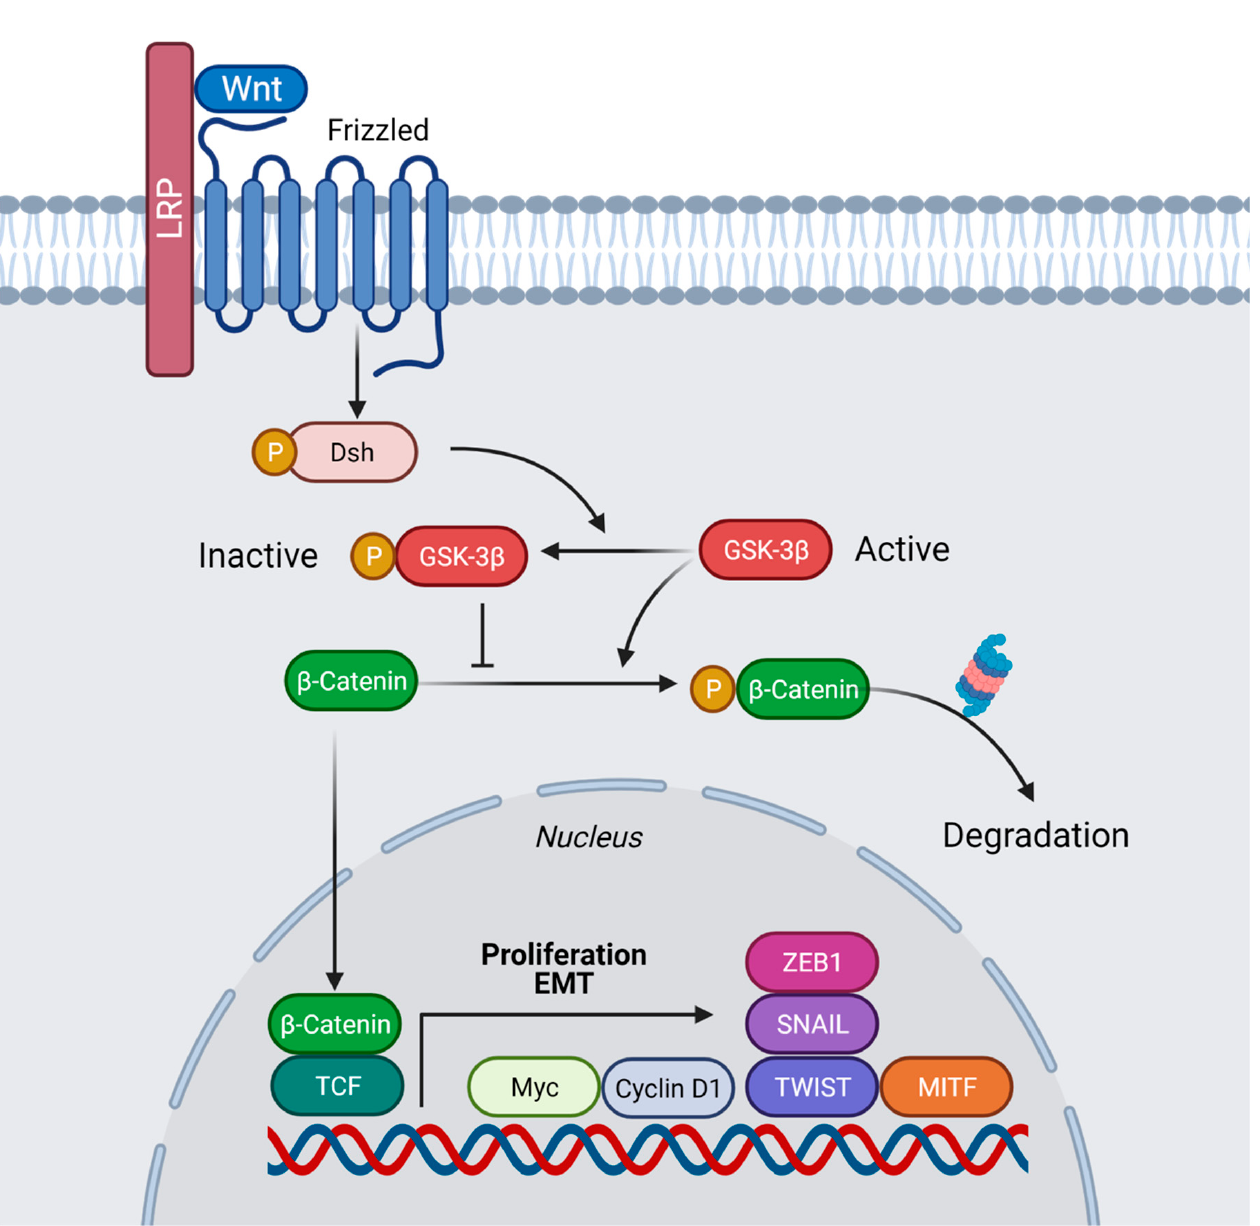
Figure 1. Model of the Wnt/ β -catenin pathway in presence of Wnt ligand. Binding of Wnt to the receptors Frizzled (Fz) and Lrp6 leads to inhibition of β -catenin degradation. After stabilization, β -catenin is translocated into the nucleus and interacts with members of the TCF/Lef-1 family of transcription factors to co-activate expression of numerous oncogenes involved in proliferation and migration, in particular Cyclin D1 and c-myc, as well as other genes, including Twist, Snail, ZEB1, and MITF, thus, facilitating EMT. Created with BioRender.com (accessed on 29 April 2022). Endocytosis is known to play a role in cancer by causing a loss of cell adhesion or morphological polarity, which can lead to the malignant transformation of cells [14–16]. For example, the small GTPases Rab proteins, which regulate vesicle transport, protein trafficking, membrane targeting and fusion, also mediate vesicle dynamics, which can work with oncogenic signaling pathways to increase tumor formation [17–20]. The dysregulated expression of oncogenic Rabs with regard to protein levels or activities, such as Rab1, Rab25, and Rab35, increases proliferation, invasion, and migration through the activation of different signaling pathways. The overexpression of Rab proteins such as Rab3d is seen in breast and lung cancer [21]. Rab2A also facilitates Erk1/2 activation, leading to